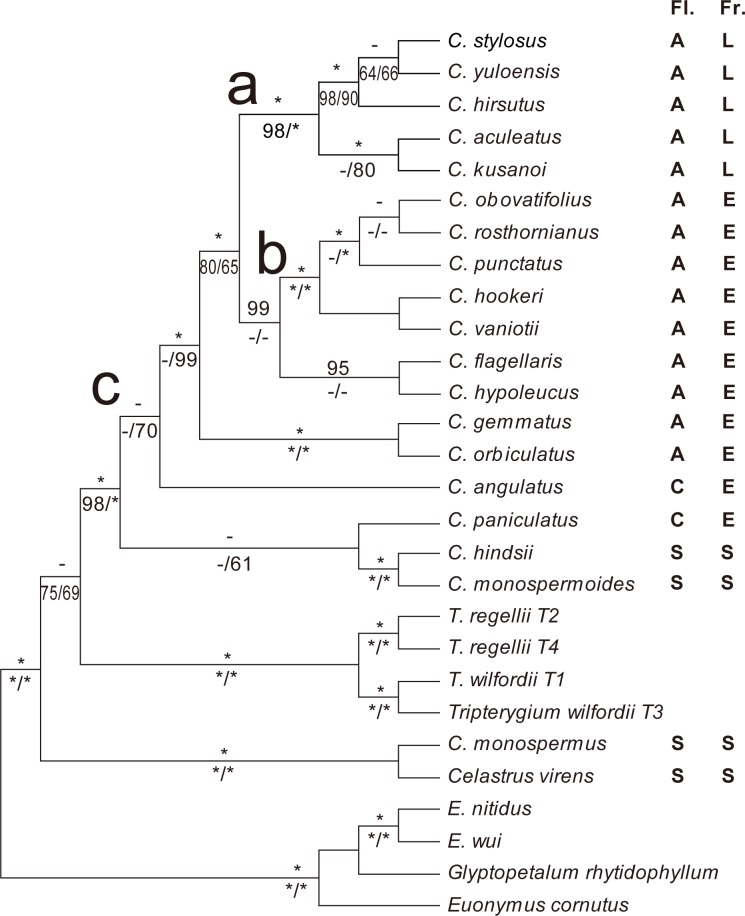
Bayesian inference of the phylogenetic relationship between Chinese Celastrus and Tripterygium from combined chloroplast and nuclear DNA datasets.Support values are presented above (BIPP, >95 is shown) and below (MPBS and MLBS, >50 is shown) the branches (-: support value <95 for BIPP or 50 for MPBS and MLBS; *: full support value). Fl.: Subgeneric classification of Chinese Celastrus based on inflorescence, fruit and seed in Flora Reipublicae Popularis Sinicae, A: Sect. Axillares; C: Sect. Celastrus; S: Sect. Sempervirentes. Fr.: Subgeneric classification of Chinese Celastrus based on fruit and seed proposed in this study, L: Sect. Lunatus, E: Sect. Ellipticus, S: Sect. Sempervirentes.